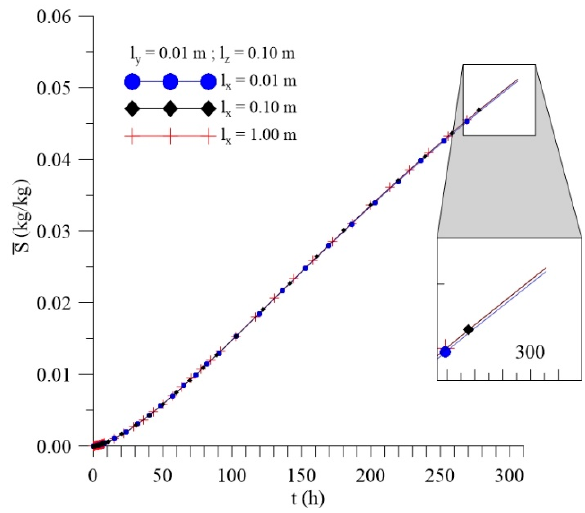
Figure 13. Kinetics of the average entrapped solute concentration fort different distances l x (Cases 8, 9, and 10).